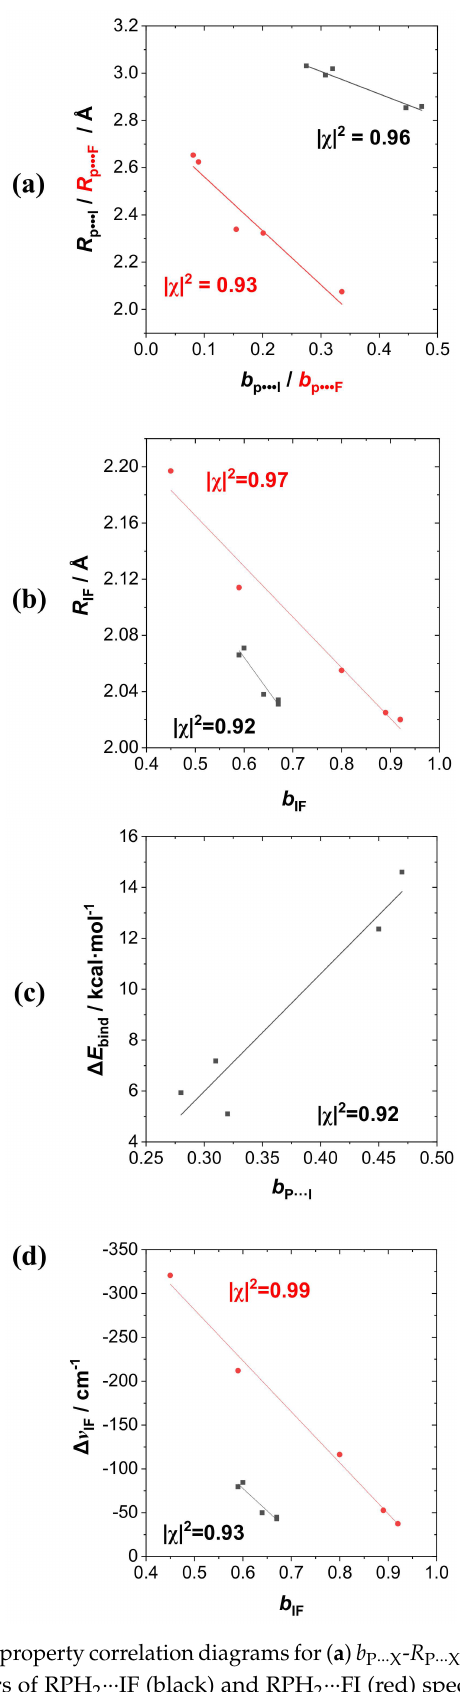
Figure 7. Bond order–bond property correlation diagrams for ( a ) b P ··· X - R P ··· X , ( b ) b IF - R IF , ( c ) b P ··· X - ∆ E bind , and ( d ) b IF - ∆ ν IF descriptors of RPH 2 ··· IF (black) and RPH 2 ··· FI (red) species, showing least-squares regression line and Pearson correlation coe ffi cient | χ | 2 for each